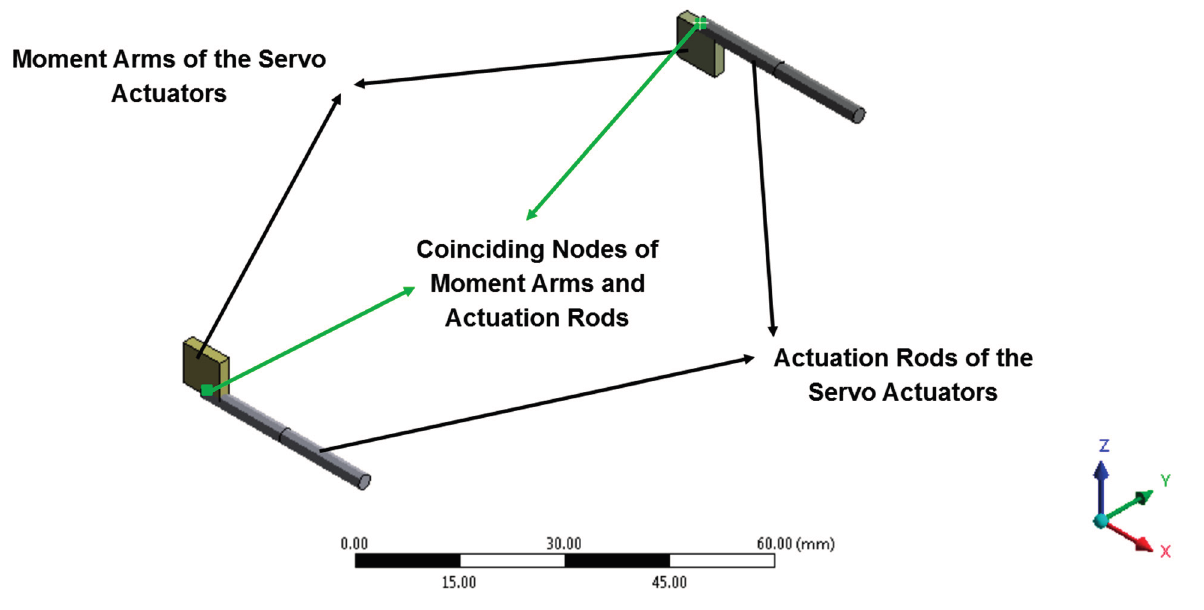
Figure 17. Coinciding edges of compliant part, rigid part, and skin parts of C part. The servo actuator moment arm and the actuation rod were connected by using the pin-joint mechanism. This pin-joint was modelled by coupling all displacements and rotations, except for rotation about y axis, at the coinciding nodes of the actuator moment arms and actuation rods. Figure 18 depicts the so-treated coinciding nodes, representing one case for the lower part actuating servo actuator and one for the upper part actuating servo actuator.